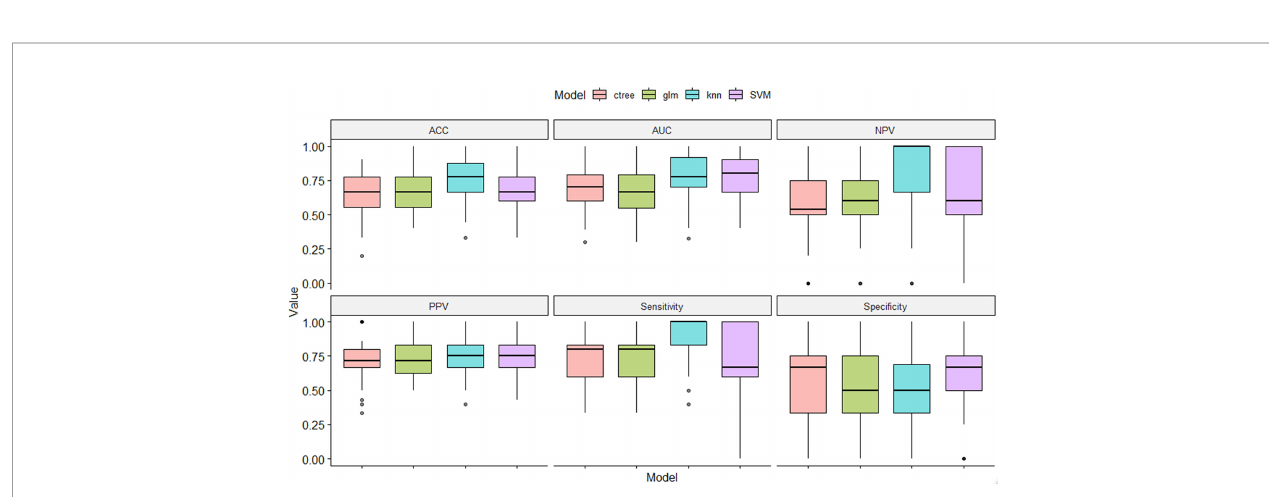
FIGURE 4 | Performance comparison of the four classi fi cation machine learning models in distinguishing benign from malignant masses.